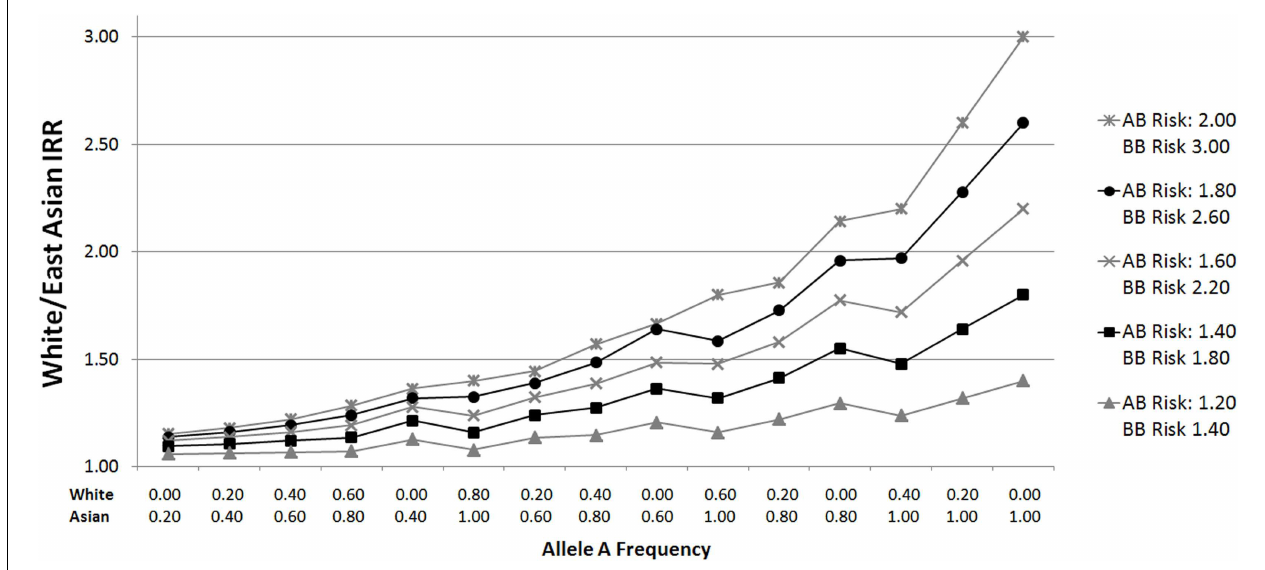
(2pq), and BB (q 2 ) genotypes are 0.04, 0.32, and 0.64, respectively, assuming HardyWeinberg equilibrium.To calculate a normalized incidence rate, the genotype proportion is multiplied by the associated GRR risk: 0.04 (1.00) + 0.32 (2.00) + 0.64 (3.00) = 2.60. Given an East Asian allele A frequency of 0.80, the East Asian normalized incidence rate is 0.64 (1.00) + 0.32 (2.00) + 0.04 (3.00) = 1.40.TheWhite/East Asian IRR is 1.86 (2.60/1.40) in this scenario.The same calculations apply forWhite/African